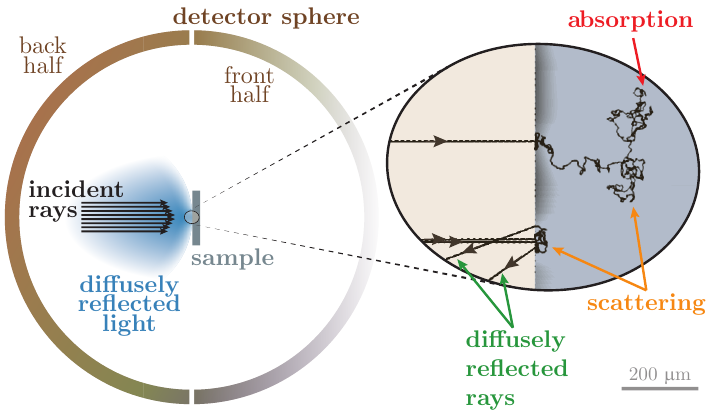
Figure 17. Schematic setup for ray tracer simulations. The inset shows a magnified version of the interaction mechanisms inside the sample as calculated within the